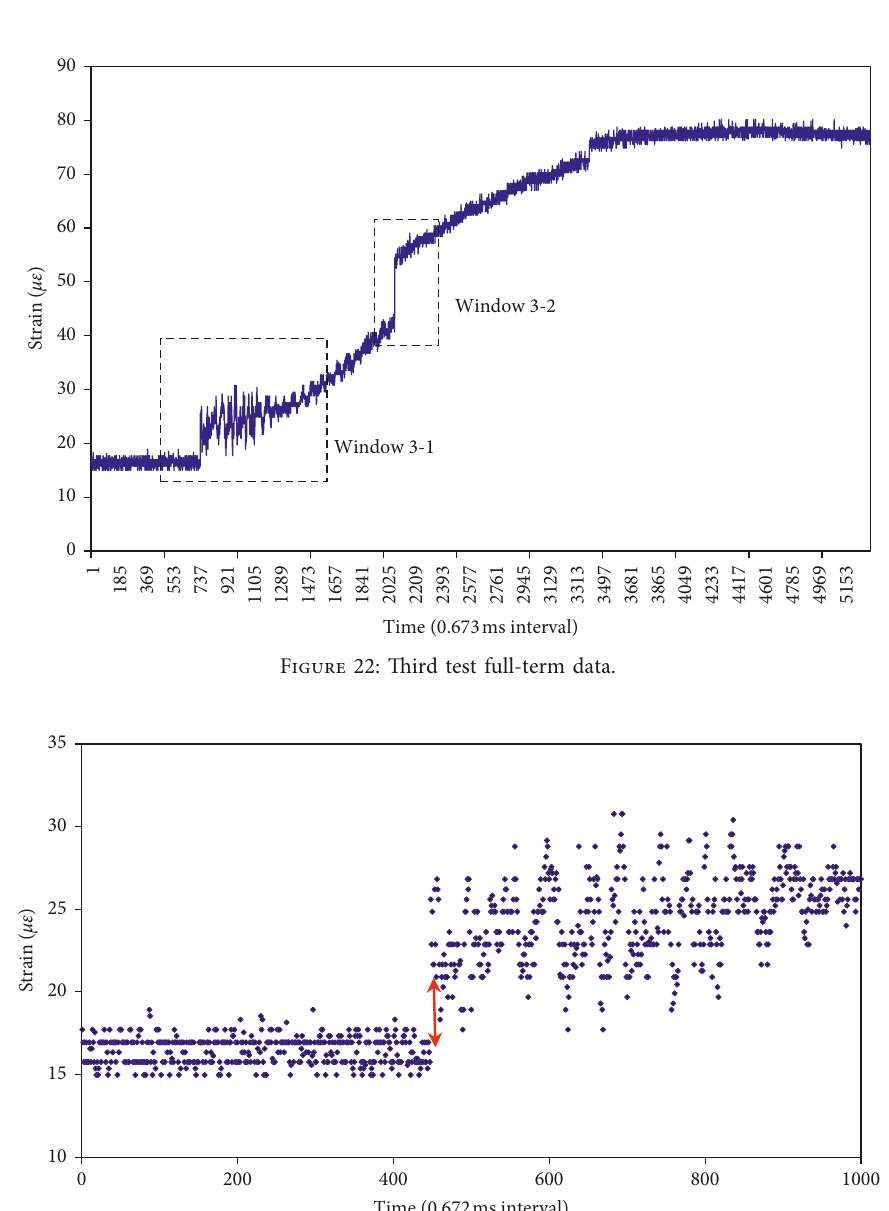
Figure 21: Second test explosion vent flame group.